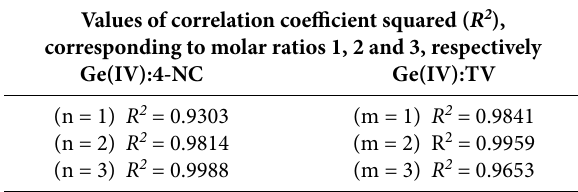
Table 2. Values of the correlation coefficient squared ( R 2 ), corre- sponding to various molar ratios of Ge(IV):4-NC and Ge(IV):TV (n and m, respectively) Values of correlation coefficient squared ( R 2 ), corresponding to molar ratios 1, 2 and 3,